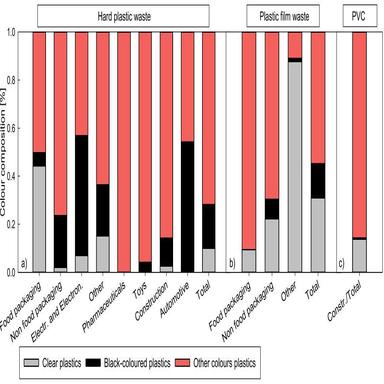
Colour composition (% on a wet weight basis) of plastic products within (a) hard plastic waste, (b) plastic film waste and (c) PVC-container waste. Electr. and Electron.: electrical and electronic equipment; Constr.: construction. (For interpretation of the references to colour in this figure legend, the reader is referred to the web version of this article.)